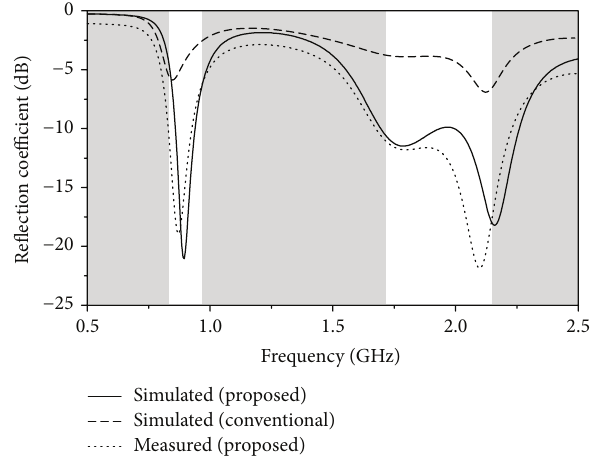
Figure 16: Simulated and measured reflection coefficients of the optimized internal antenna. The simulated performances for the conventional topology optimization are also